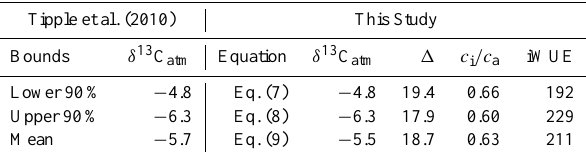
Table 3. Early Eocene δ 13 C atm , (cid:49) , c i /c a , and intrinsic water use efficiency (iWUE) estimates. δ 13 C atm (‰) results of Tipple